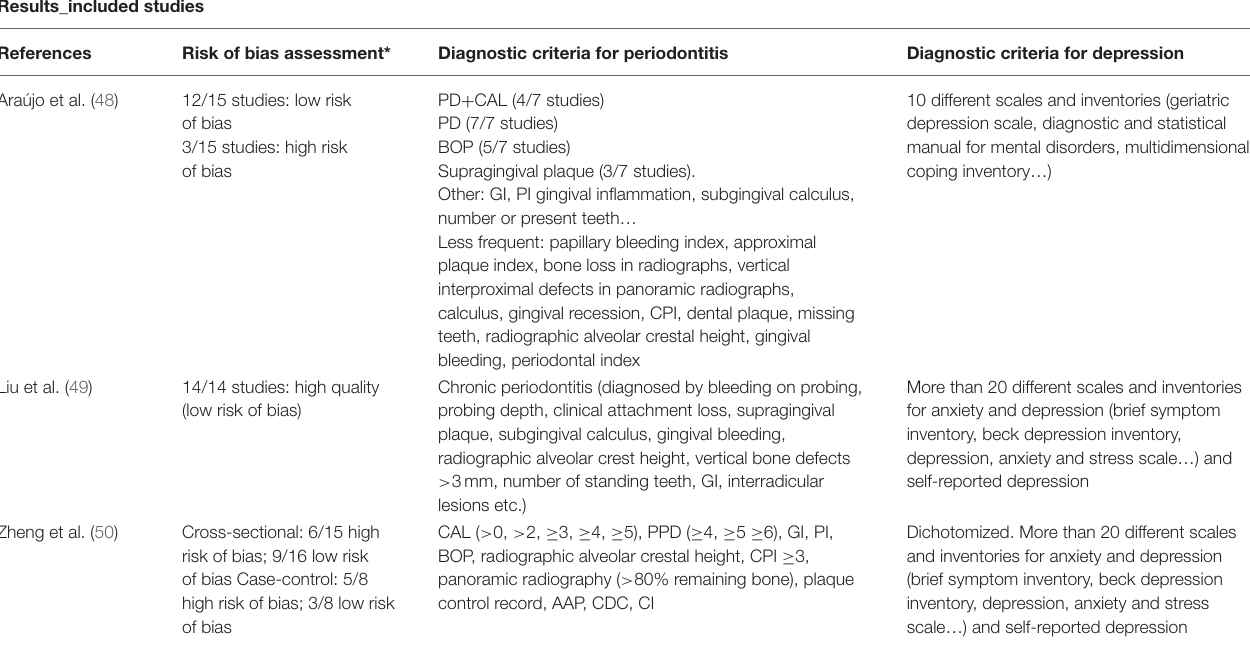
TABLE 1B | Main characteristics of systematic reviews dealing with the association between periodontitis and depression: results (risk of bias, diagnostic criteria). Results_included